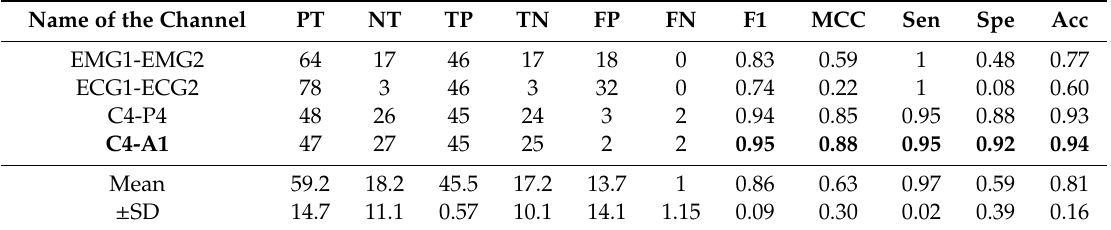
Figure 6. Power spectral analysis of the channels such as ( A ) the ECG1-ECG2 channel, ( B ) EMG1- EMG2 channel, ( C ) C4-P4 channel, and ( D ) C4-A1 channel of the healthy subjects. Table 2. Performance of the subjects (bruxism and healthy) classification using the novel 20-fold cross-validation model of the HML classifier.